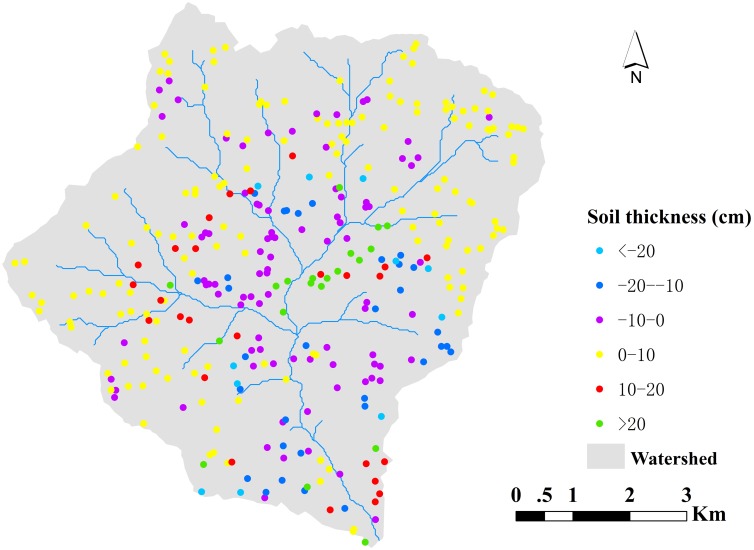
Spatial distribution maps of prediction deviation of AL soil thickness produced by RF.